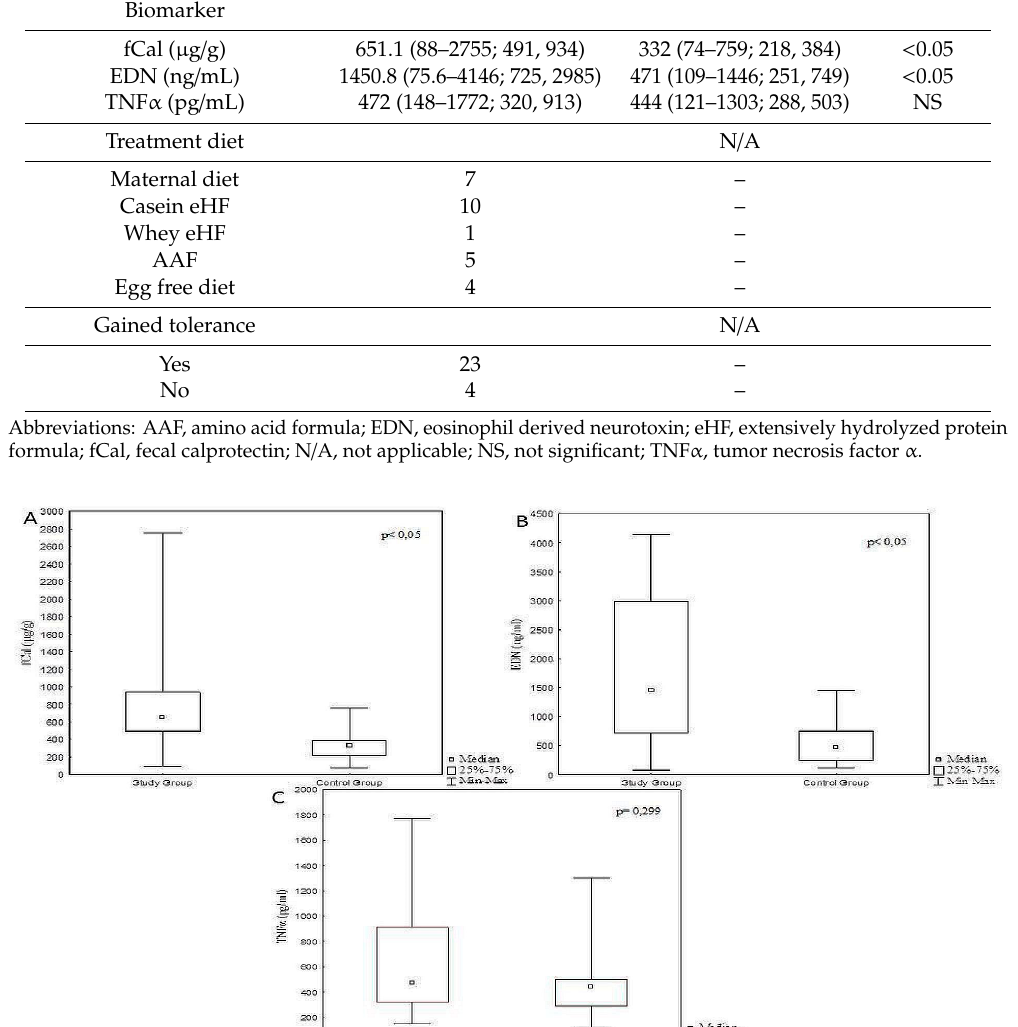
Figure 3. Receiver operating characteristics (ROC) curve of fecal calprotectin ( A ), eosinophil derived neurotoxin ( B ) and TNF α ( C ) for prediction of FPIAP. Abbreviations: NPV, negative predictive values; PPV, positive predictive values; ACC, accuracy. The best diagnostic performance, regarded as significant increase in AUC, sensitivity, and specificity was reached in a combination of fCal and EDN (Table 2). Adding TNF α did not improve the diagnostic usefulness. Detailed statistical analyses of markers concentration in both groups are presented in Table 2 and Figure 3.